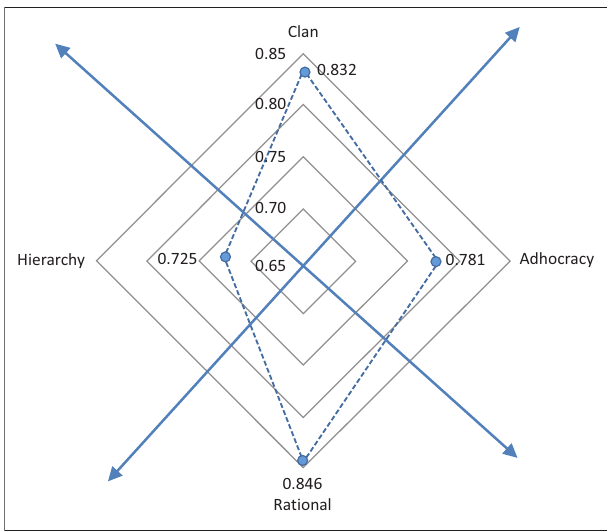
FIG URE 4: The organisational culture profile of the university.